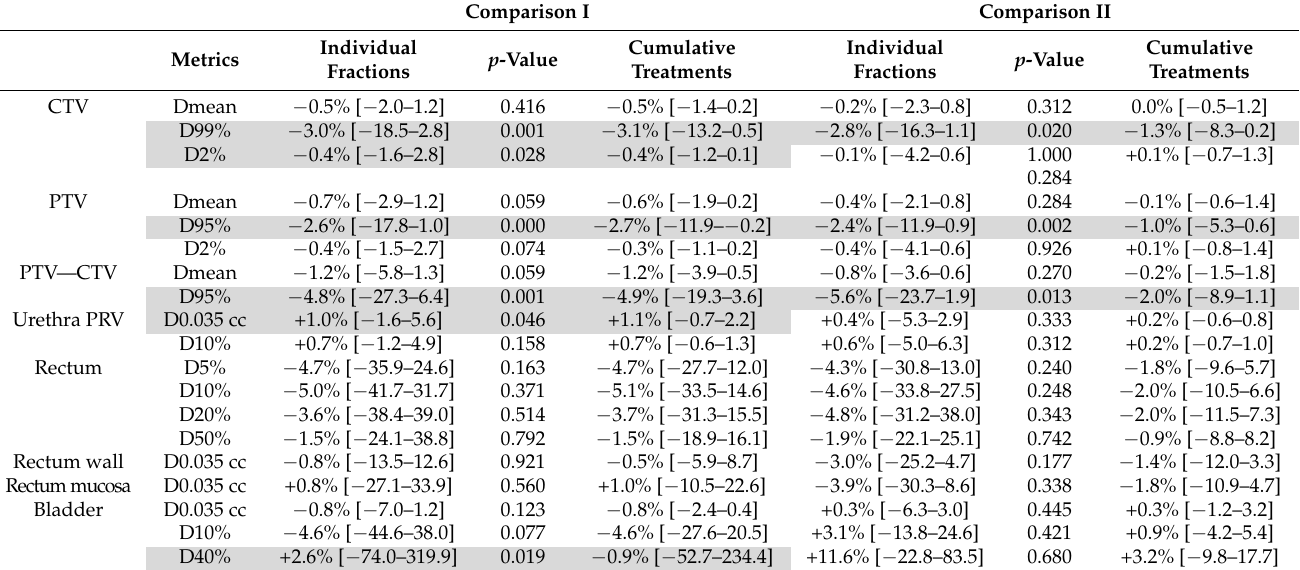
Table 3. Mean and range (over all fractions and patients) of the percentage differences in target and OARs dosimetric parameters between the delivered and planned dose distributions (comparison I) and between the two motion-inclusive dose distributions reconstructed from case B and case A prostate motion data (comparison II). In the latter, for the individual fractions, only the 25 fractions that required an intervention due to prostate motion outside the tolerances were considered, while the cumulative mean differences were obtained by summing the gated and non-gated fractions as required. Statistically significant differences ( p < 0.05) are highlighted.